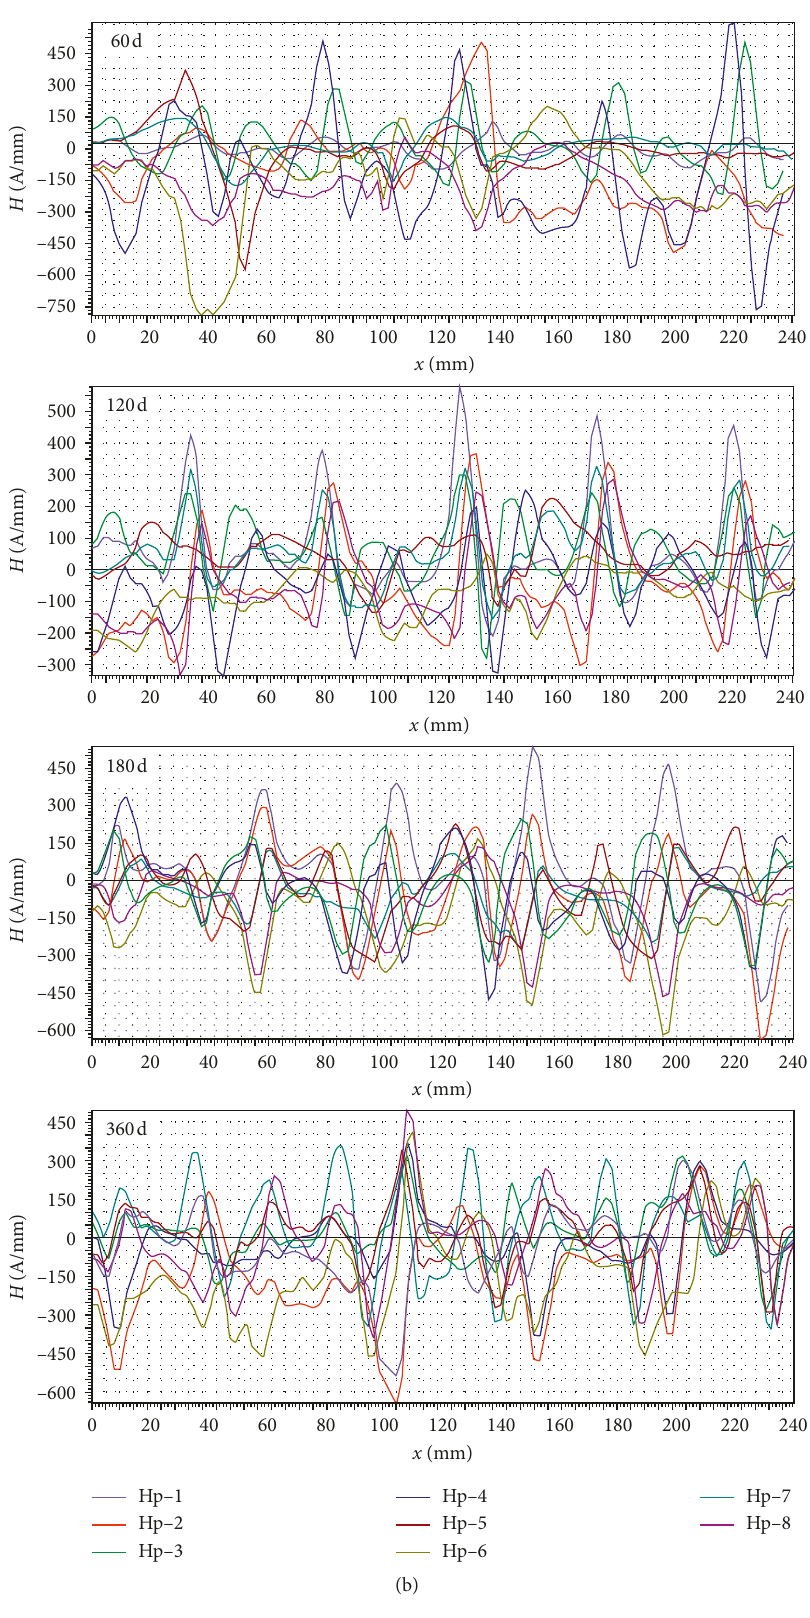
Figure 10: Evolution law of surface magnetic field distribution. (a) Welded structure processed by VSR. (b) Welded structure unprocessed by